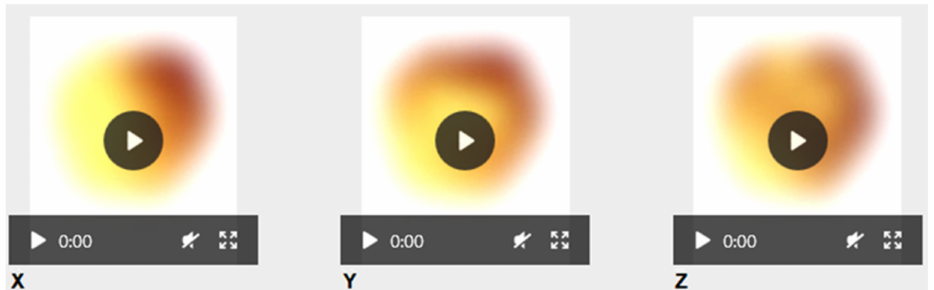
Figure 3. Global trend response item animations. As the six local outlier response items in the first part of the experiment, three trend response items immediately replace the seen stimulus in the second part of the